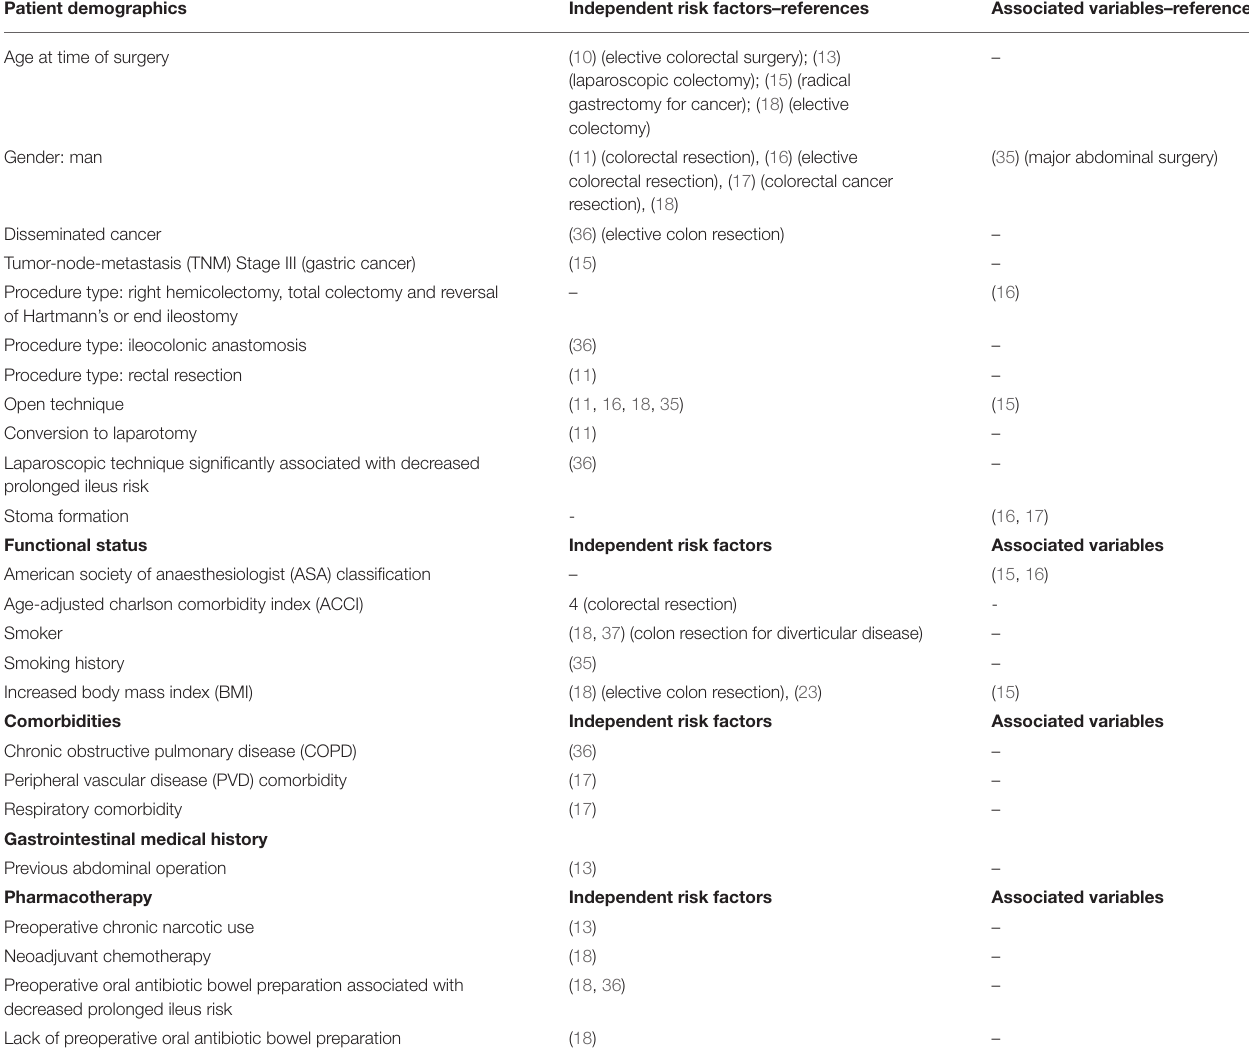
TABLE 2 | Known risk factors associated with